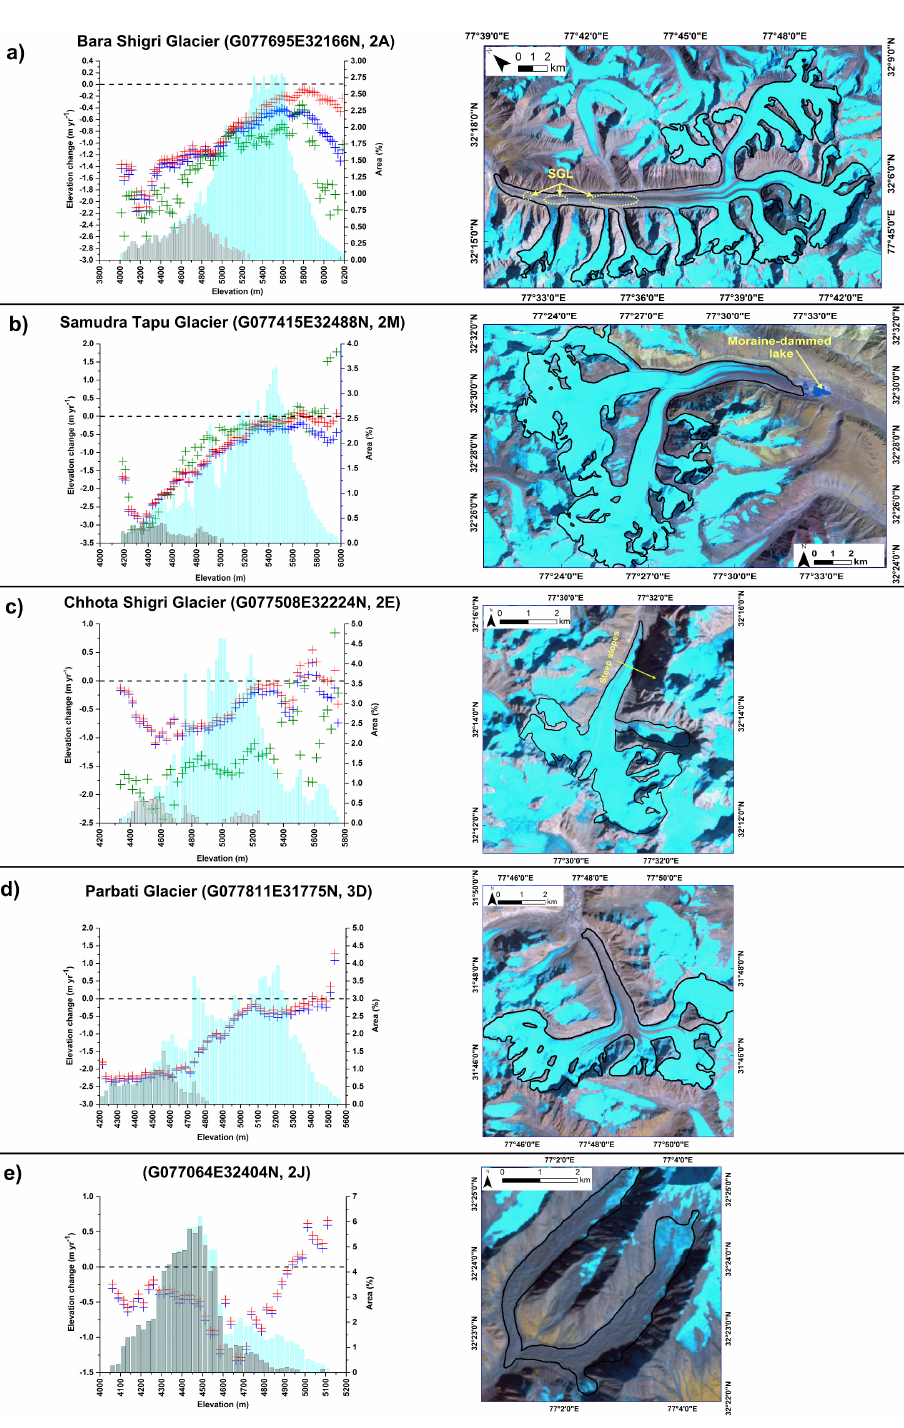
Figure 5. The left and right panel show the hypsometric elevation change plots and the catchments of ( a ) Bara Shigri, ( b ) Samudra Tapu, ( c ) Chhota Shigri, ( d ) Parbati and ( e ) G 077064 E 32404 N glaciers. The cyan and gray columns show the fractions of total glaciated area and debris covered area in the corresponding bins. The surface of Bara Shigri is covered by several supraglacial lakes, few of them indicated as SGL in ( a ). The blue “ + ” in the plots represent the median elevation change (2000–2012) in the corresponding bins after correcting for the C- and X- band penetration bias. The red “ + ” indicate the uncorrected median elevation change during 2000–2012. Green “ + ” represent the median elevation change during